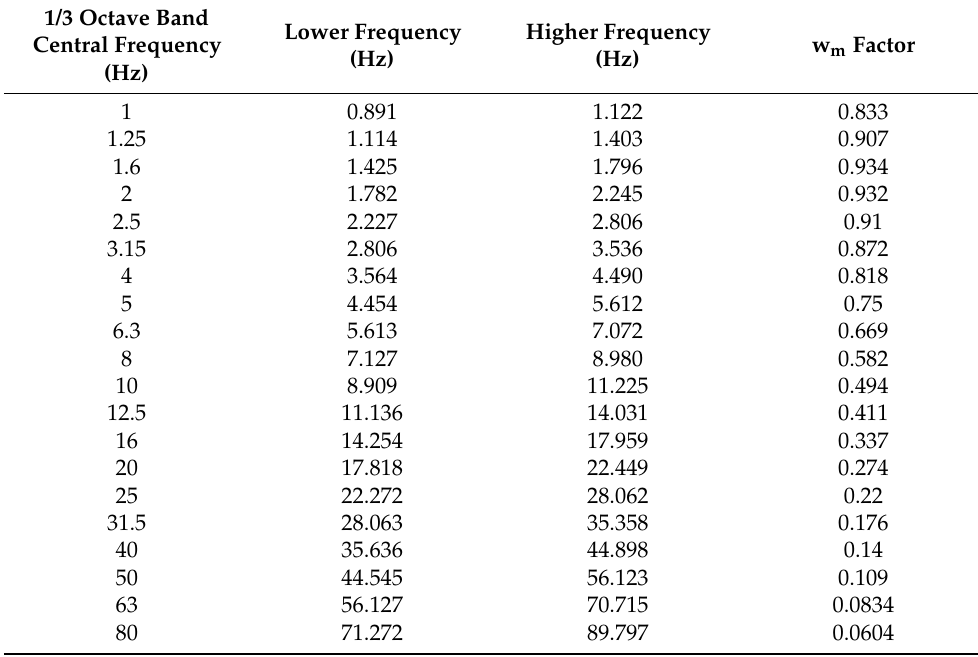
Table 1. Weighting values for third-octave bands center frequencies. Reference: weighting values Wm for third-octave bands center frequencies of 1 Hz to 80 Hz (ISO 2631-2:2011).